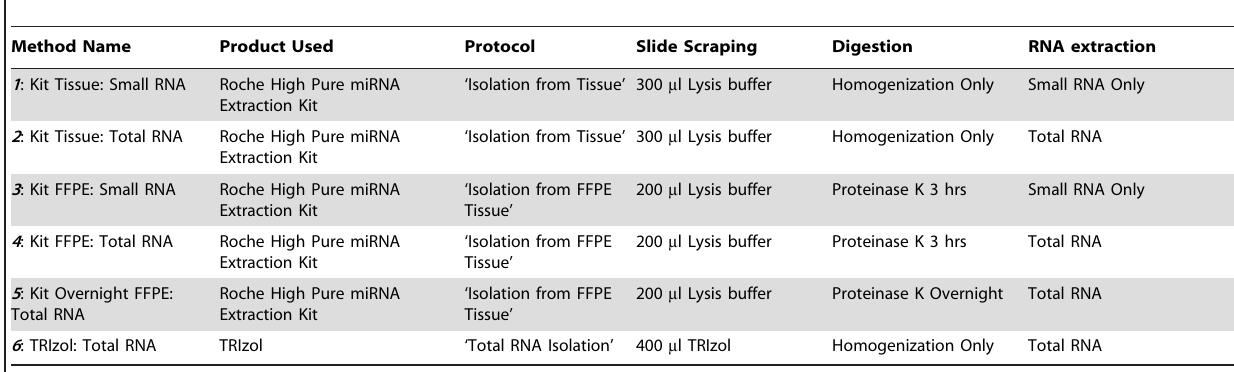
Table 1. Modified protocols used for the extraction of RNA from archived bone marrow aspirate